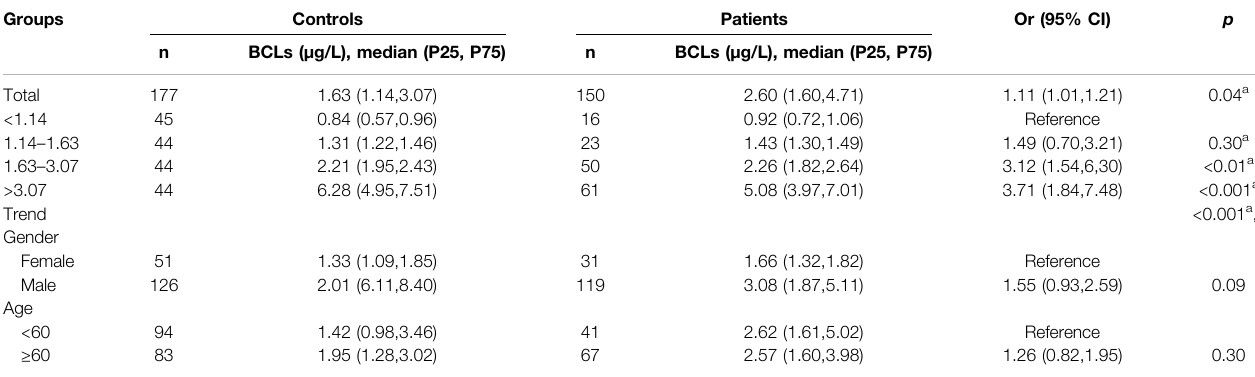
TABLE 1 | BCLs in the survey population and the associations between ESCC risk and BCLs. Groups